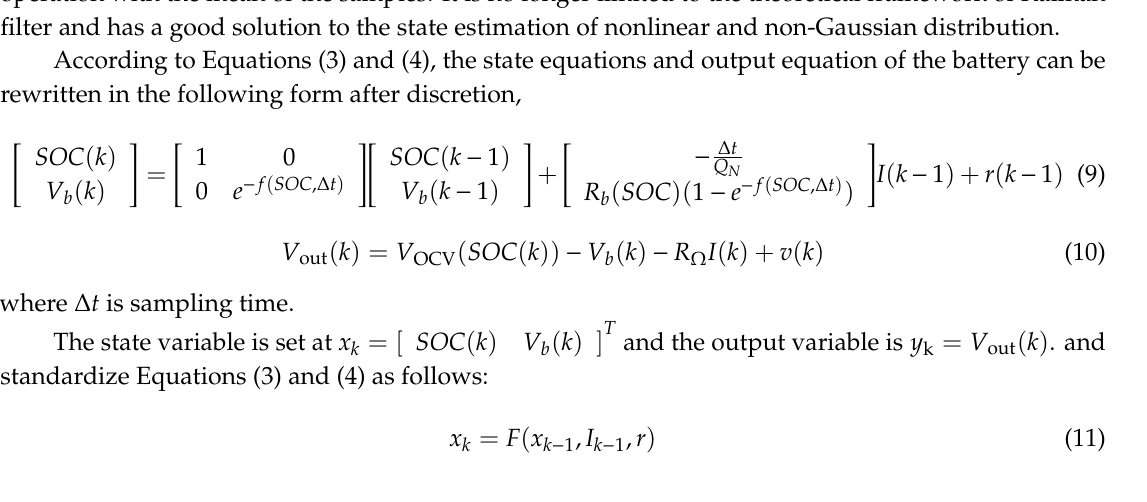
Figure 9. Voltage prediction error.